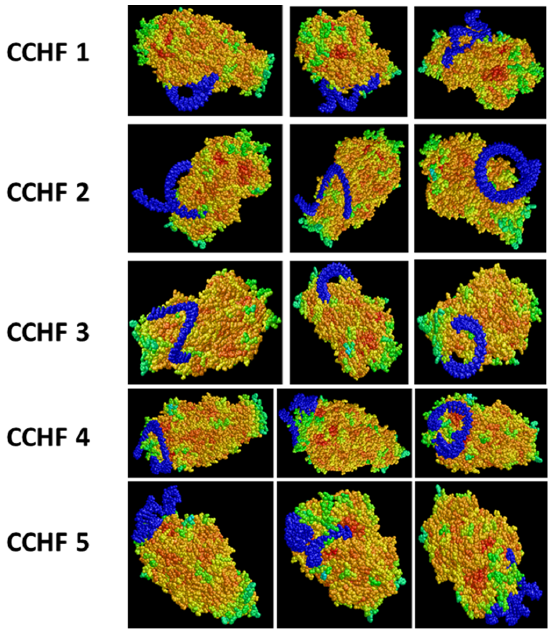
Figure 10. Three different views (presented in the three columns) of each of the top five highest affinity aptamers (blue) from ref. [29] bound to the full CCHF envelope protein [30]. At the time of writing this article, studies are still ongoing in a BSL ‐ 4 laboratory with viable the IbAr 10200 strain of the CCHF virus and the top five aptamer candidates. Op ‐ timal doses have not yet been determined for plaque reduction, but preliminary data seems to indicate that affinity is not always the best predictor of antiviral efficacy or host cell (SW ‐ 13 cell line) ‐ entry blockage. Case in point, the blue aptamer “tightness” of bind ‐ ing (i.e., the amount of free space or contact between a given aptamer and the multicolored envelope protein in Figure 10) does not appear to be well correlated with plaque reduction efficacy in vitro, because the CCHF 2 aptamer has thus far demonstrated the best (up to 69%) reduction in plaque ‐ forming units (pfus), but it shows some noteworthy spatial gaps between itself and the envelope protein’s surface in some of the views in Figure 10. The CCHF 4 and 5 aptamers which also performed well, but not as well as CCHF 2, in terms of pfu reduction (41% and 33.9%, respectively), appear to be bound more tightly to the envelope protein in Figure 10. Thus, in the end, efficacy against CCHF progression may boil down to where (locus on the envelope protein) the aptamer is binding and interfering with viral binding and host cell entry and may not be so dependent on how tightly the aptamer binds, if it binds less relevant regions or epitopes on the envelope protein. There ‐ fore, overall, static 3D modeling appears somewhat successful or at least useful in this case, but one must not rely solely on binding proximity and “tightness” or on affinity predictions when attempting to predict how an aptamer may interfere with a receptor– ligand system.